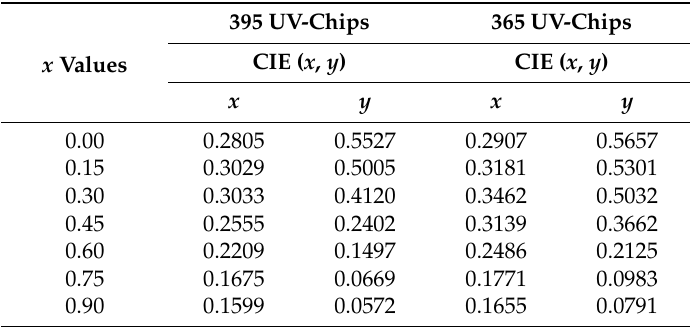
Table 3. Parameter of chromaticity coordinates based on Sr 0.90 − x Ca x Al 2 O 4 :0.05Eu 2+ , 0.05Dy 3+ phosphors with 365 nm and 395 nm UV-Chips under 20 mA forward-bias current.